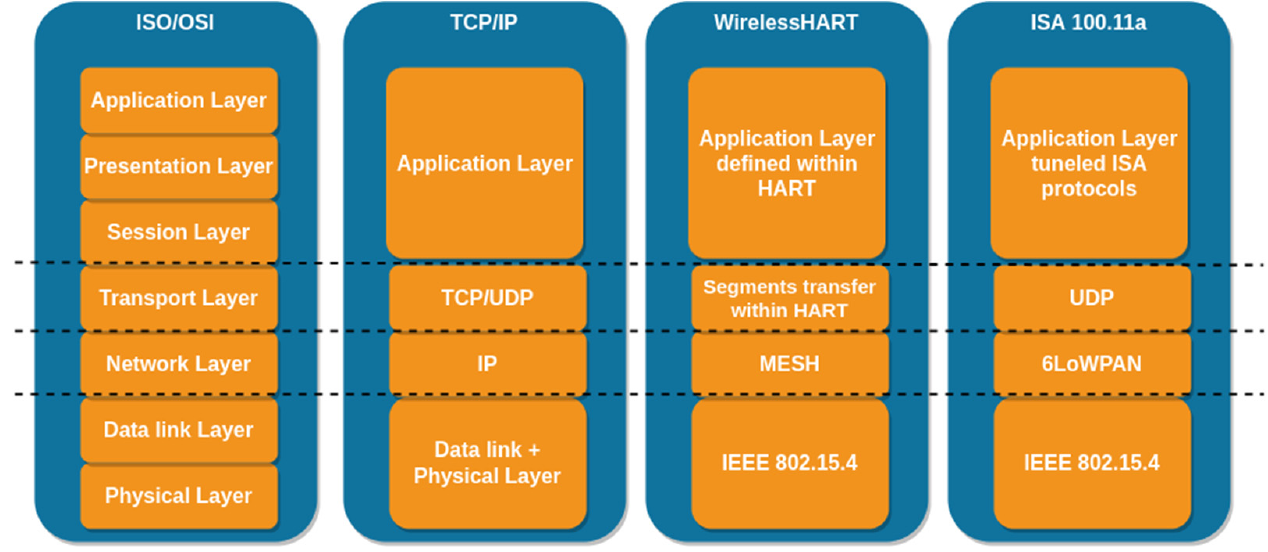
Figure 9. Position of WirelessHART and ISA100.11a within RM OSI model.